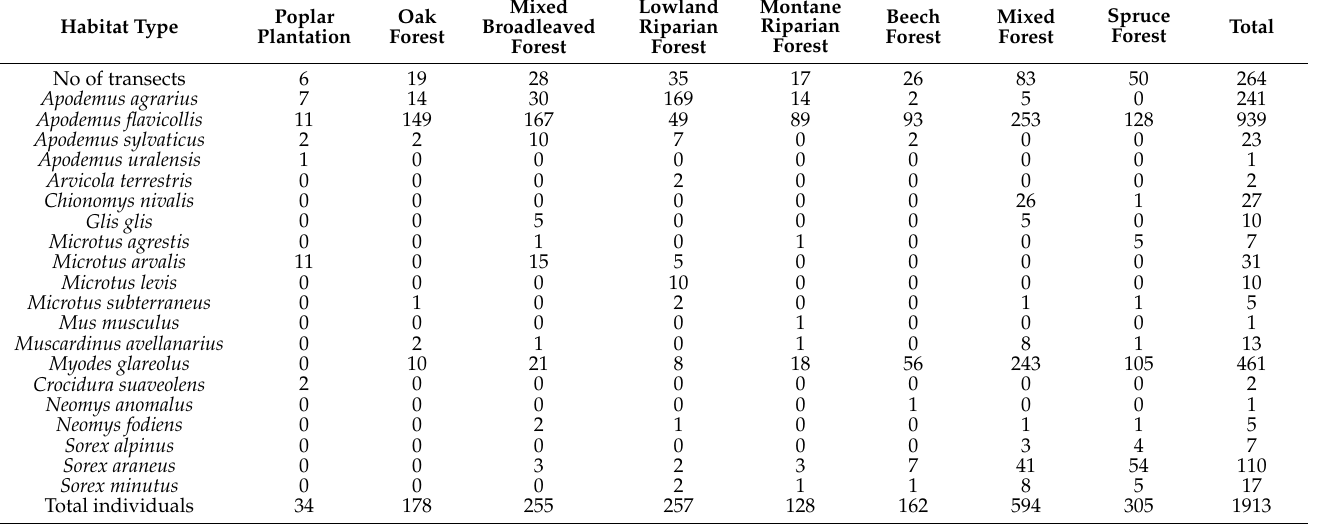
Table A1. Small mammal trapping results in all the transects in the eight surveyed forest types, some with multiple temporal replicates in various